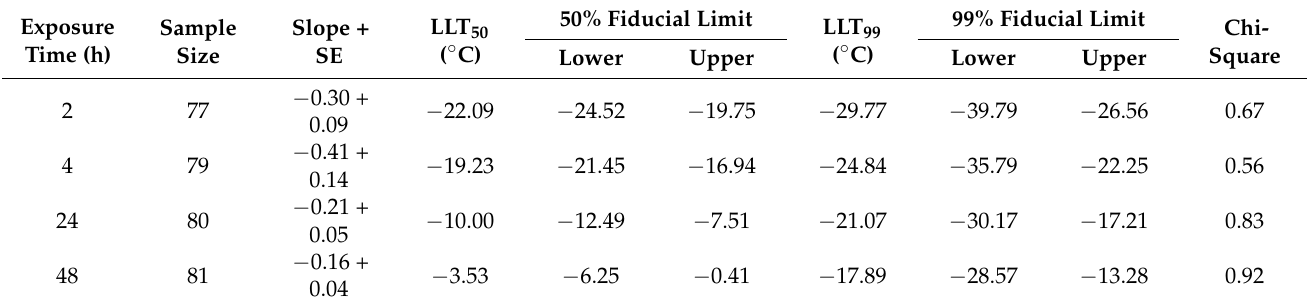
Table 2. LLT 50 ( ◦ C) and LLT 99 ( ◦ C) of overwintering larvae with different exposure durations. Table 2. LLT (°C) and LLT (°C) of overwintering larvae with different exposure durations. 50 99